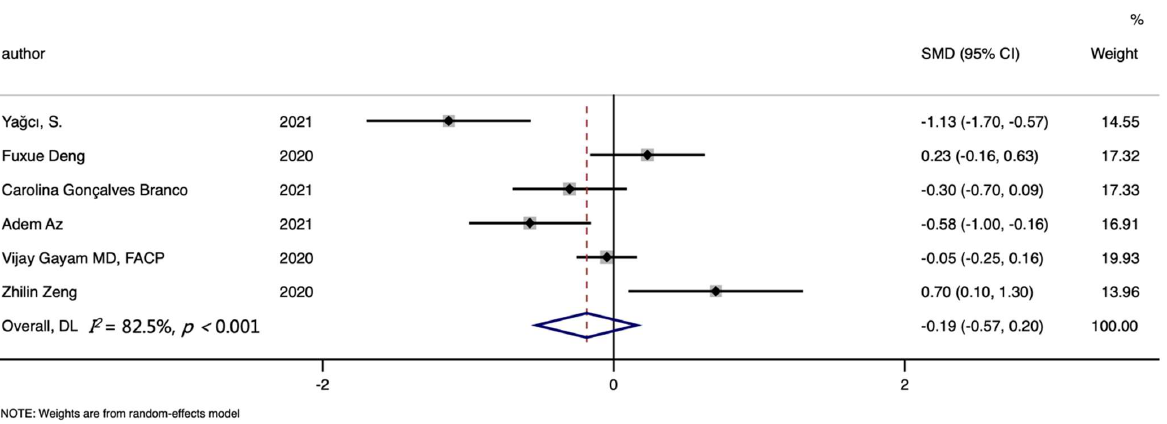
Figure 6. Forest plot of standard mean difference (SMD) with corresponding 95% confidence intervals (CIs) of studies [10,30,38–41] on hemoglobin levels in non-survivors and survivors. The solid diamond and horizontal line represent the study-specific effect and 95%CI, respectively; the size of the grey square is positively correlated with the weight distributed to each study in the meta-analysis. The center of open diamond with the vertical dashed line expresses the pooled SMD, and the width expresses the pooled 95%CI.